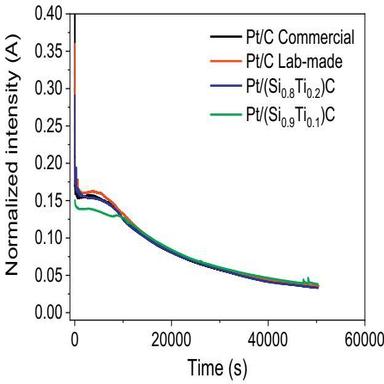
Chronoamperometry tests of the different employed catalysts. Conditions: 20 C, 1 M H2SO4, 1V vs RHE.